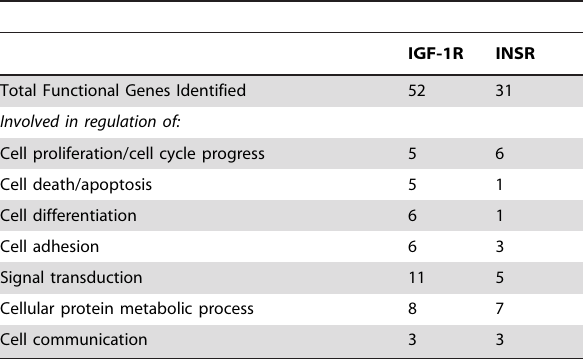
Table 2. Functional clustering of gene annotations using the DAVID